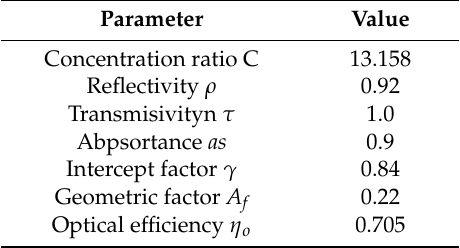
Table 2. Optical parameters for the Parabolic Trough Collector